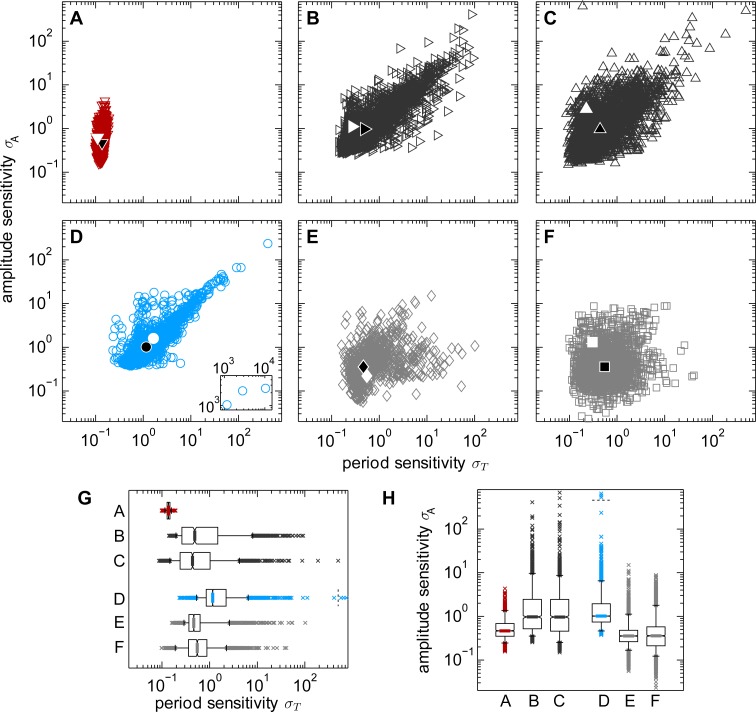
Sensitivities for models of circadian and calcium oscillations.A-C: Circadian models. (A) Model for mammalian cells [37] (compare Fig 1A and 1C red triangles); (B) model for D. melanogaster [46]; (C) model for A. thaliana [47]. D-F: Calcium models. (D) Phenomenological model [38] (compare Fig 1B and 1C blue circles); (E) open-cell model [48]; (F) closed-cell model [49]. Black symbols denote median values, white symbols the sensitivities for the parameter set published together with the model. G, H: Box-plots of the period (G) and the amplitude (H) sensitivity distributions for the models from A-F. The schemes and further details of the models are given in Fig 6.